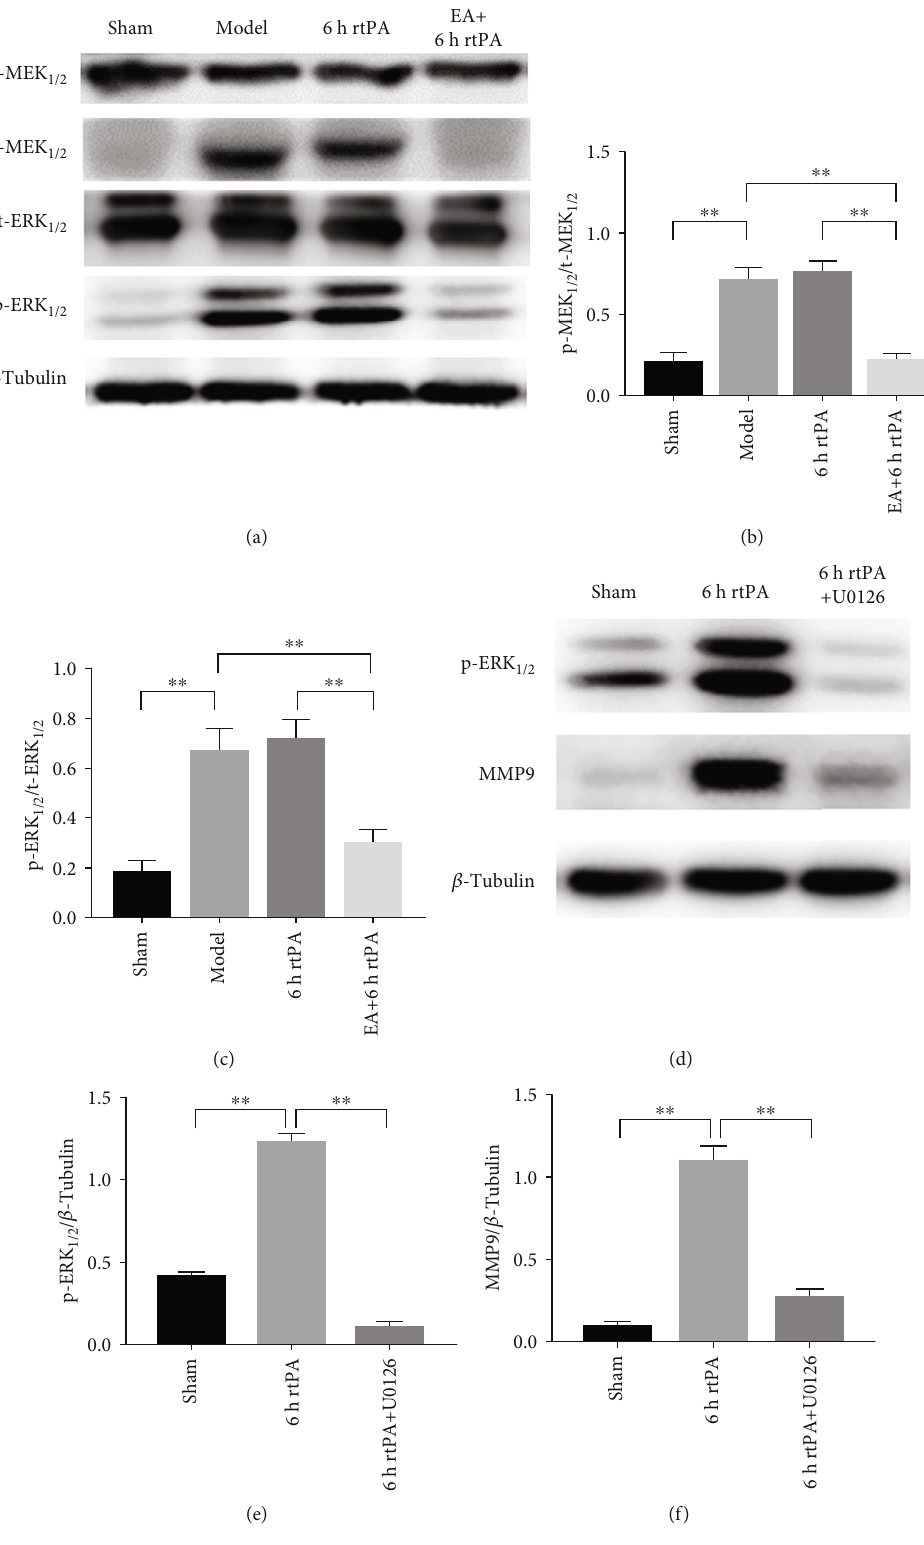
Figure 7: Western blots showing the e ff ects of EA on the ERK1/2-MMP9 pathway in each group ( n = 6 rats). (a) Representative immunoblots showing the levels of t-MEK1/2, p-MEK1/2, t-ERK1/2, and p-ERK1/2 in the sham, model, 6 h rtPA, and EA+6 h rtPA groups. (b) Relative levels of p-MEK /t-MEK . (c) Relative levels of p-ERK /t-ERK . (d) Representative immunoblots showing the levels of p- 1/2 1/2 1/2 1/2 ERK1/2 and MMP9 in the sham, 6 h rtPA, and 6 h rtPA+U0126 groups. (e) Relative levels of p-ERK1/2. (f) Relative levels of MMP9. ∗∗ indicates p < 0 : 01